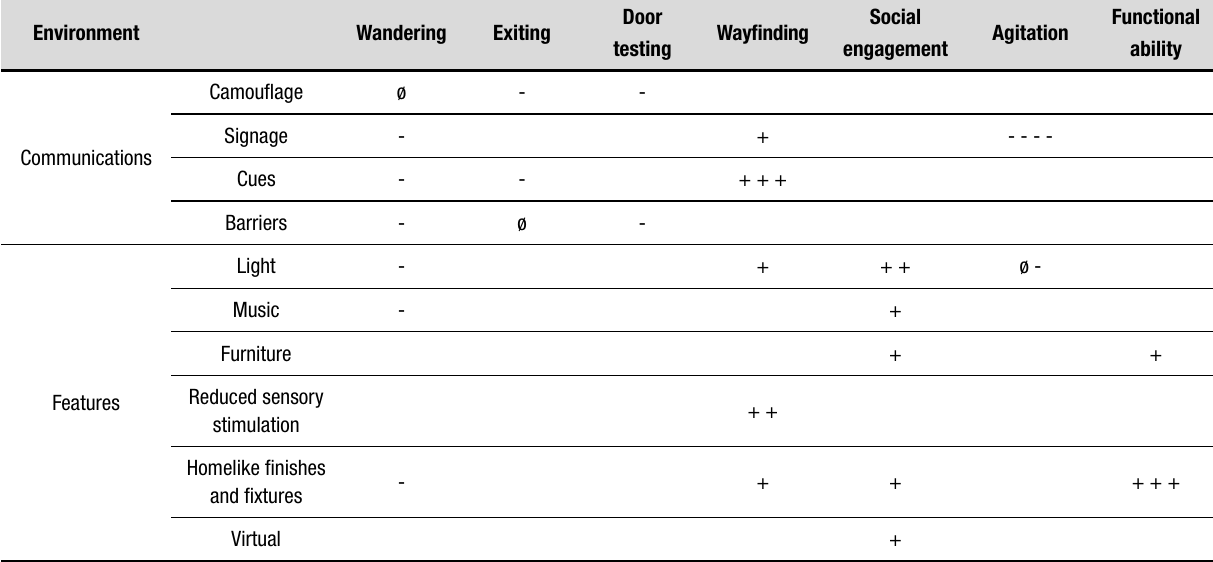
Table 3. Overview of environmental characteristics, related interventions, and the respective